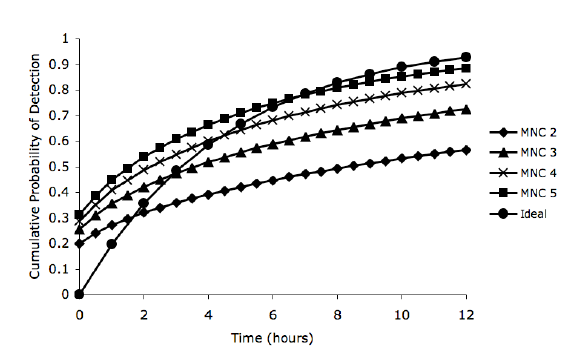
Fig.14. Average CPD of Final USDEA Cluster Fields Communications Range = 11 kyd